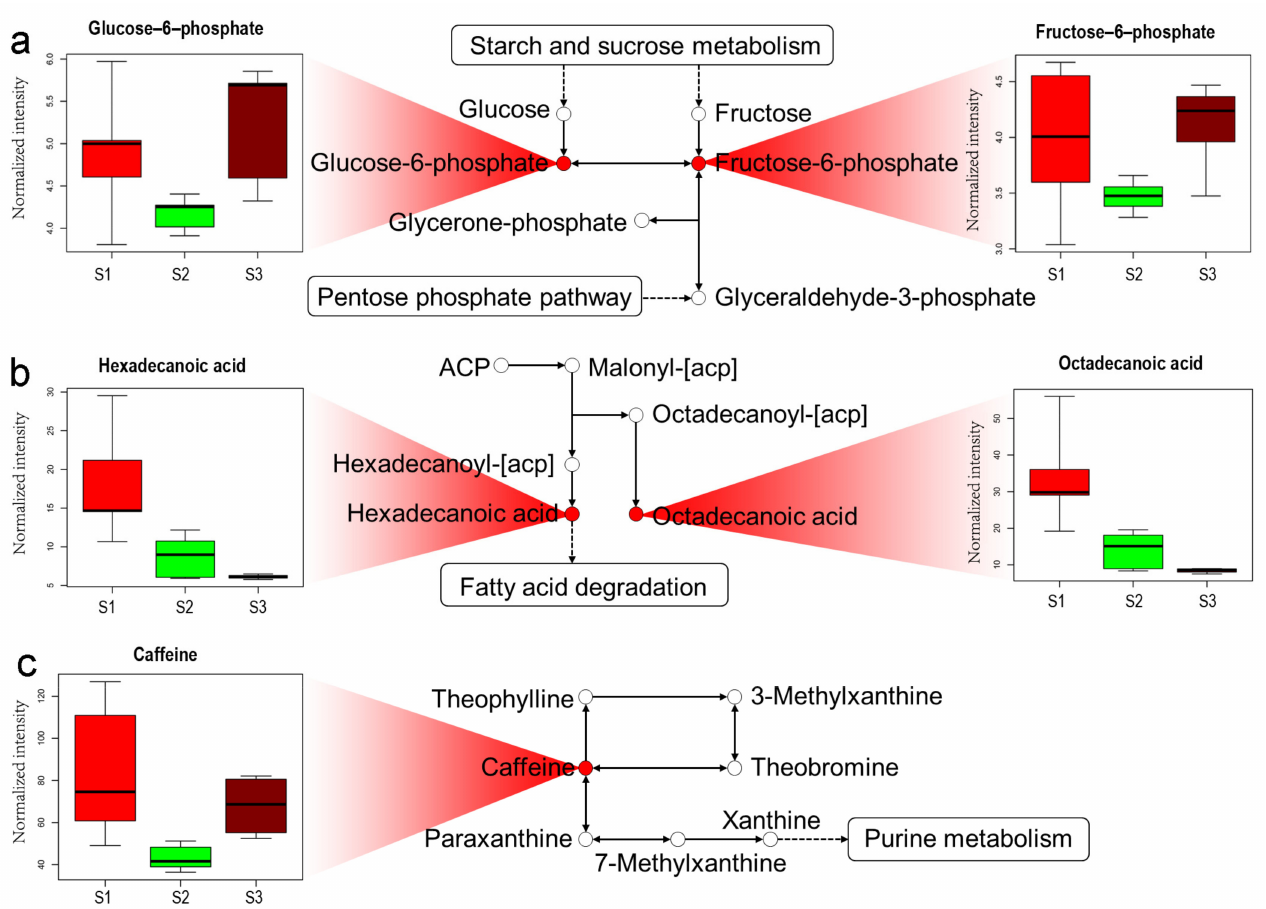
Figure 4. The metabolic pathways were affected mainly by different fertilizations: ( a ) glycolysis/gluconeogenesis; ( b ) fatty acid biosynthesis; ( c ) caffeine metabolism. The y-axis boxplots (–) indicate the median values, the top/bottom ranges of the boxes indicate the upper/lower quartiles, and the top/bottom whiskers indicate the maximum/minimum distribution of the